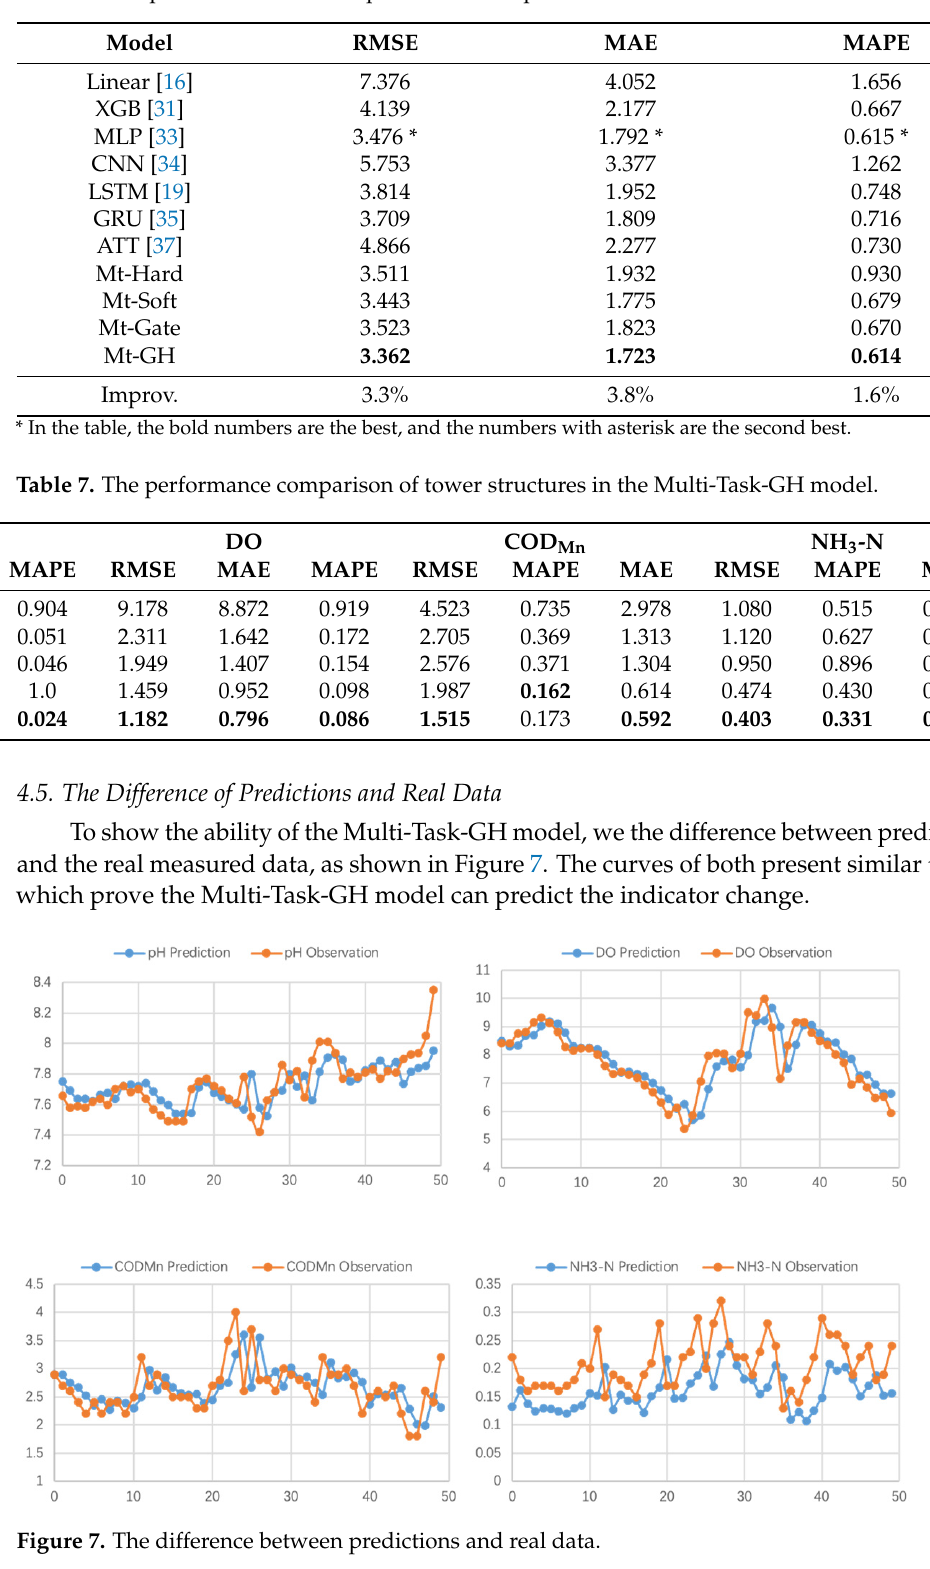
Figure 7. The difference between predictions and real data.